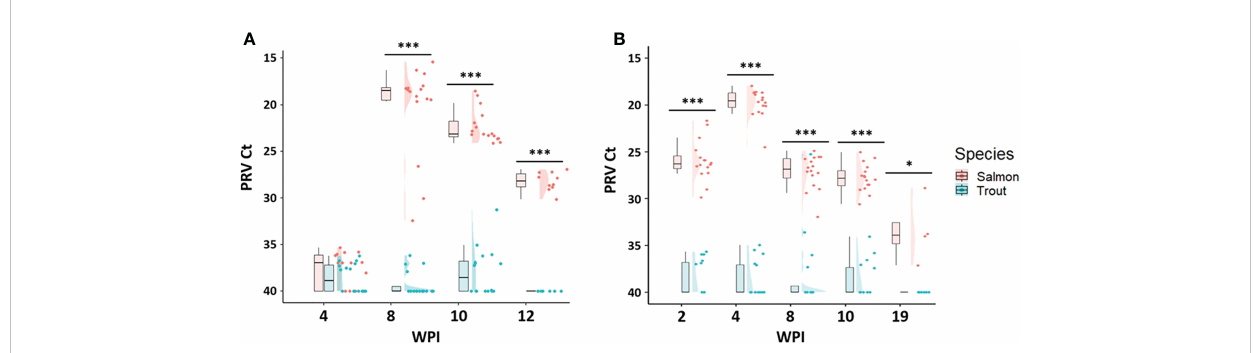
FIGURE 4 Raincloud plots for comparison of PRV-1 viral RNA load between salmon and brown trout in post-smolt stage after (A) cohabitation, and (B) IP challenge Asterisk (* P < 0.05; *** P < 0.001) indicate signi fi cant differences based on Welch ’ s two sample t-test. At 19 WPI 4 remaining fi sh were tested for viral